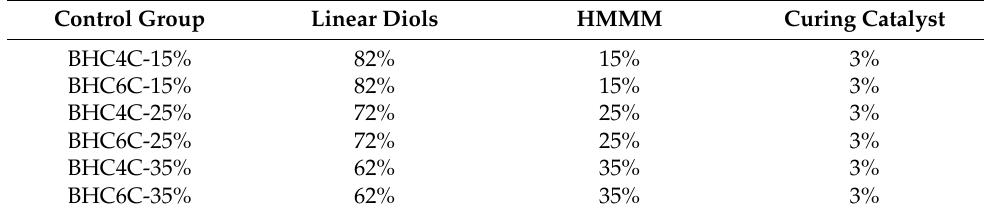
Table 2. Formulation of MF coatings for the control group (wt. %).